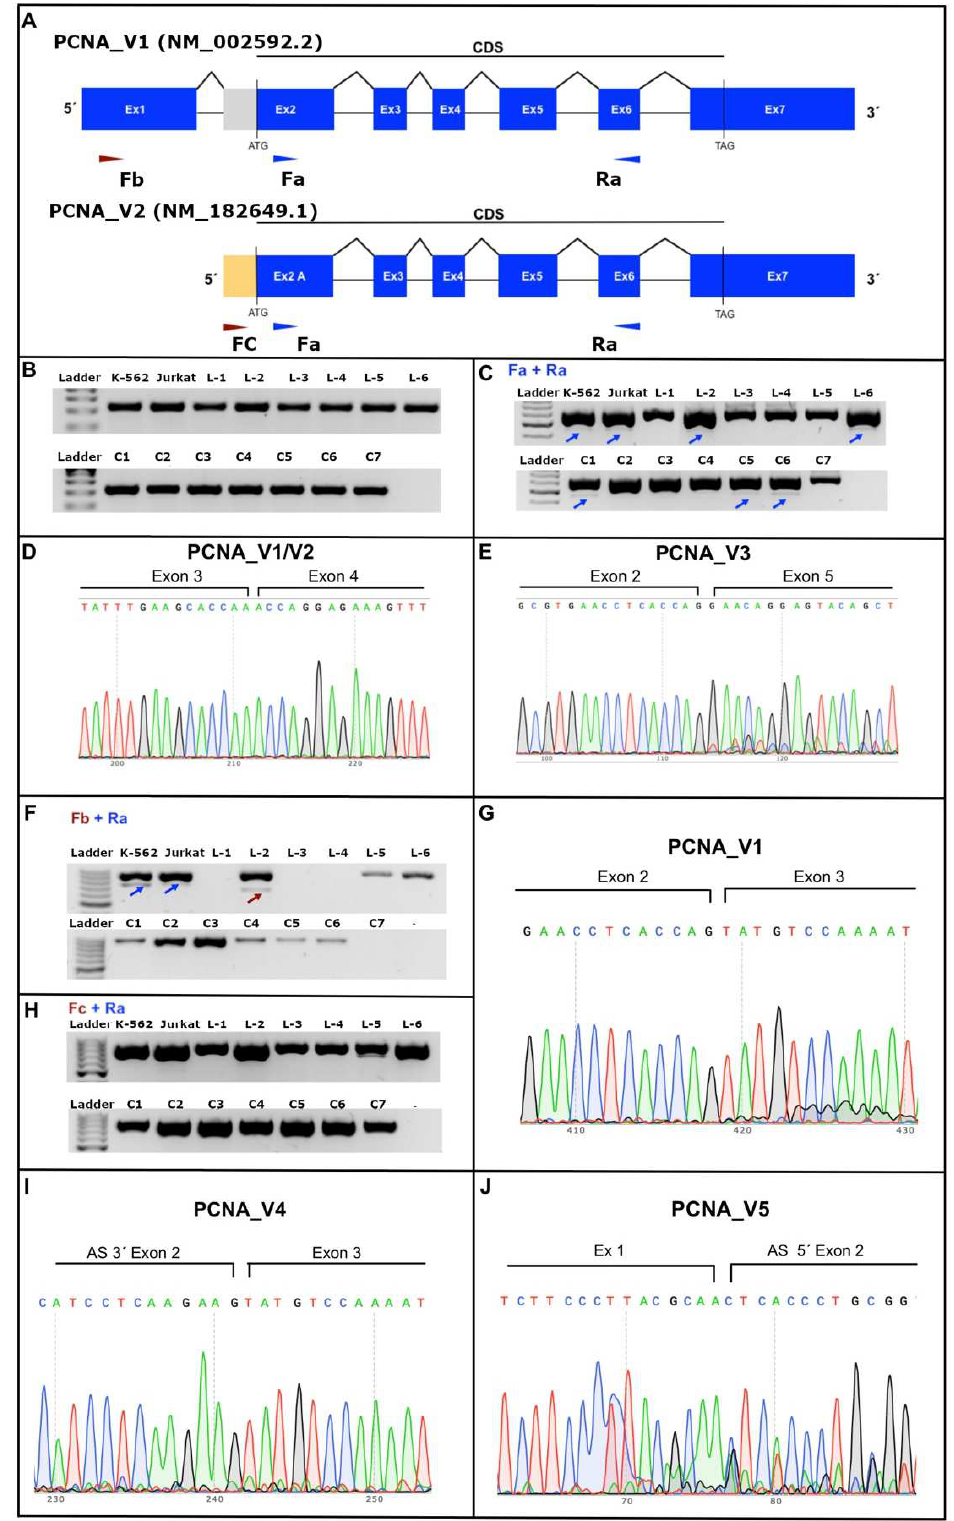
Figure 3. PCNA transcript variants expressed in healthy individuals, B-ALL patients and B-ALL cell lines. ( A ) The figure shows the primers designed to amplify the PCNA_V1 (NM_002592.2) and PCNA_V2 (NM_182649.1) primers. ( B ) The figure shows the housekeeping RPL4 expression in the cell lines (K562 and Jurkat), B-ALL patients (L1-L6) and healthy controls (C1-C7). ( C ) Amplification of the consensus sequence of PCNA transcript variants (NM_002592.2/NM_182649.1) using the pri- mers Fa + Ra; note a PCR product of the ~600 bp PCNA canonical sequence, as expected. Addition- ally, we observed other PCR products of less size (~500 bp; blue arrows). ( D ) PCNA sequence of the